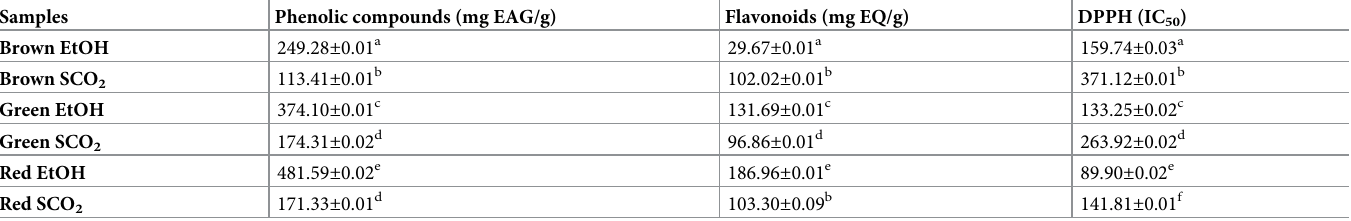
EtOH–Extract obtained by ethanolic extraction; SCO 2 : Extract obtained by supercritical extraction; IC 50 : Lower values of IC 50 indicate higher activity of radical